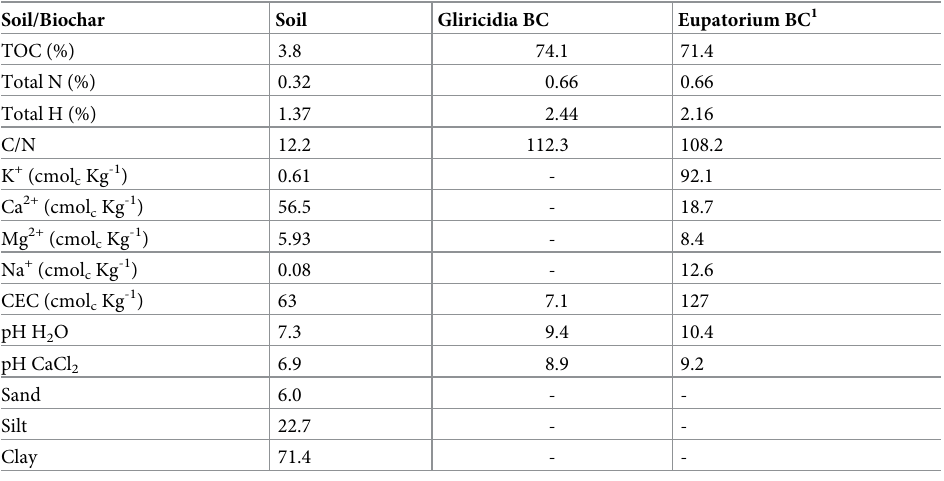
Table 1. Properties of heavy clay soil and biochars.